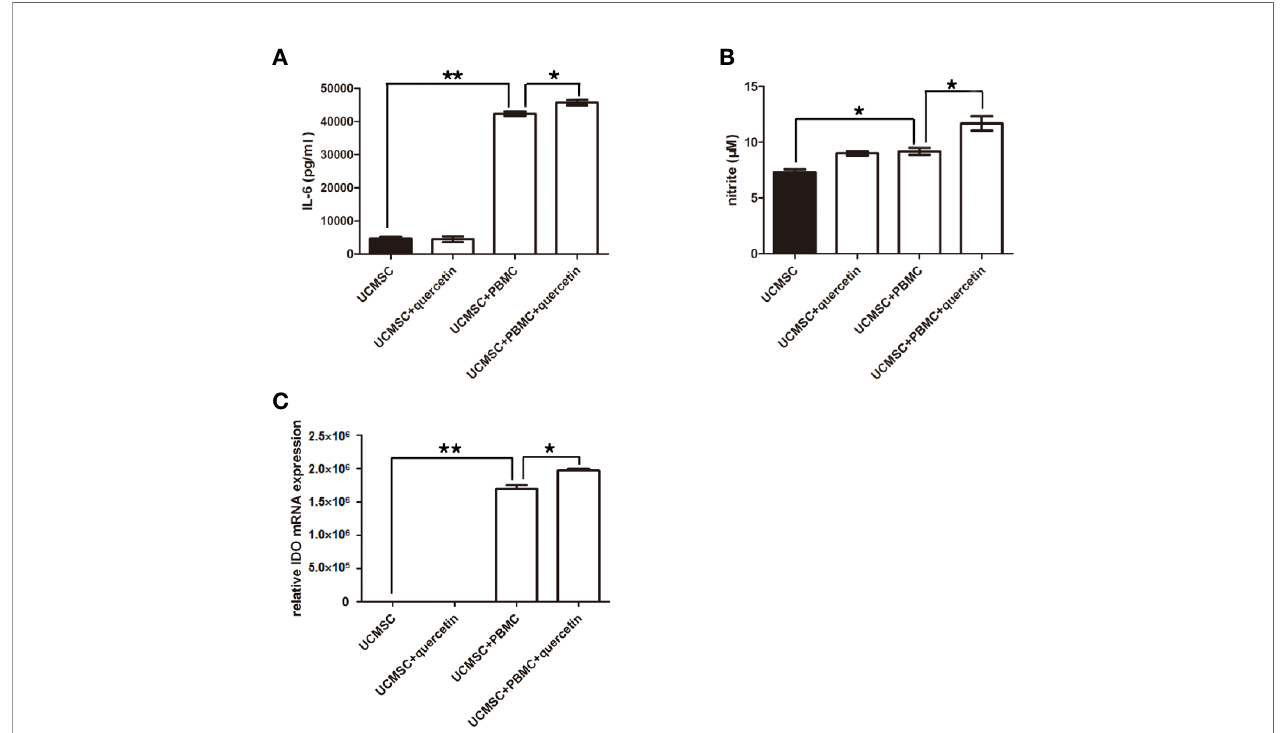
FIGURE 5 | Changes in anti-in fl ammatory molecules in UCMSCs. TNF- a /IFN- g -activated PBMCs (1:1 ratio) in the presence or absence of quercetin for 3 days. The anti-in fl ammatory molecules IL-6 (A) , NO (B) , and IDO (C) were determined by ELISA, Griess assay and RT-PCR.. UCMSCs overexpressed IL-6, NO, and IDO in the coculture system with PBMCs. Quercetin enhanced the effect. Mean ± SEM, n = 3. * P < 0.05, ** P <